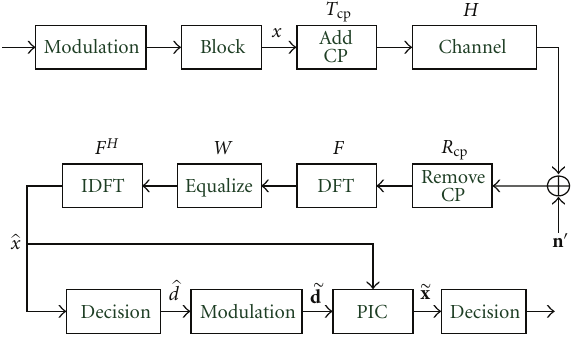
Figure 5: Block diagram of PIC in SCBT system.